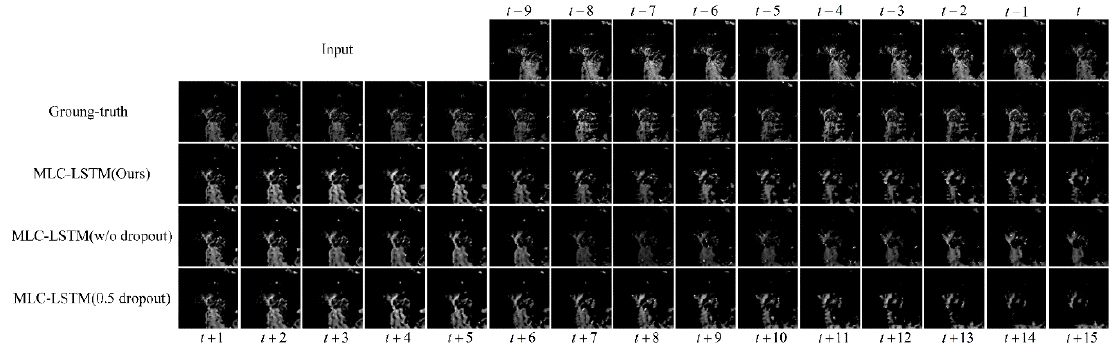
Figure 6. The extrapolation results for the echo at Hangzhou, China, 8 August 2016, 23:07 UTC. The last three rows show the results obtained by our model, MLC-LSTM without the dropout and MLC-LSTM with 0.5 rate dropout respectively.